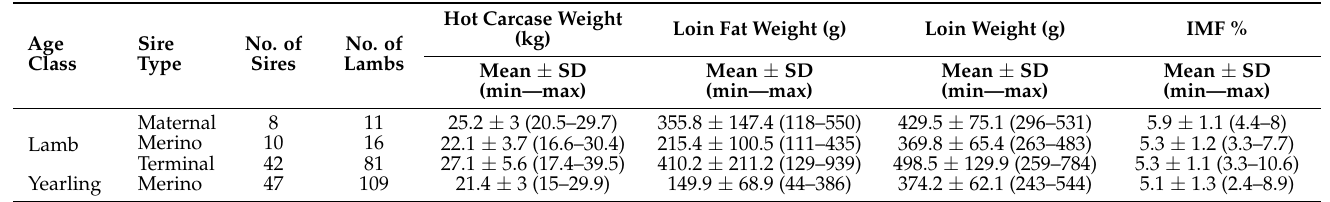
Table 2. Number of sires, number of animals ( n = 217) and their unadjusted mean ± SD (min—max) for the phenotypic traits included in base model analyses.